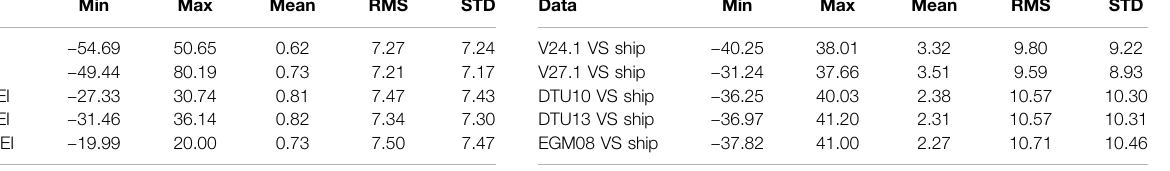
TABLE 3 | Validation results of marine gravity models with NCEI shipboard gravity data, unit: mGal. Data Min Max Mean RMS STD